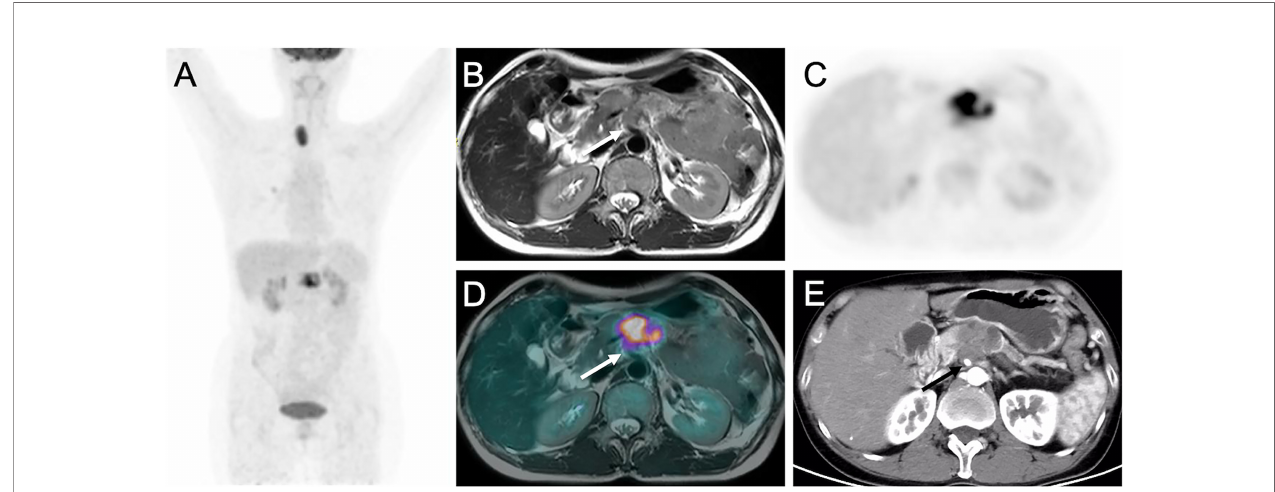
FIGURE 2 | Images of pancreatic ductal adenocarcinoma in 52-year-old woman with vascular invasion. (A) MIP from PET/CT showing increased uptake in pancreas. (B) T2WI, (C) Delayed PET image, (D) Corresponding PET/MR imaging fusion image and (E) Arterial phase CT image show the mass in the body of pancreas encasing superior mesenteric artery (arrows).